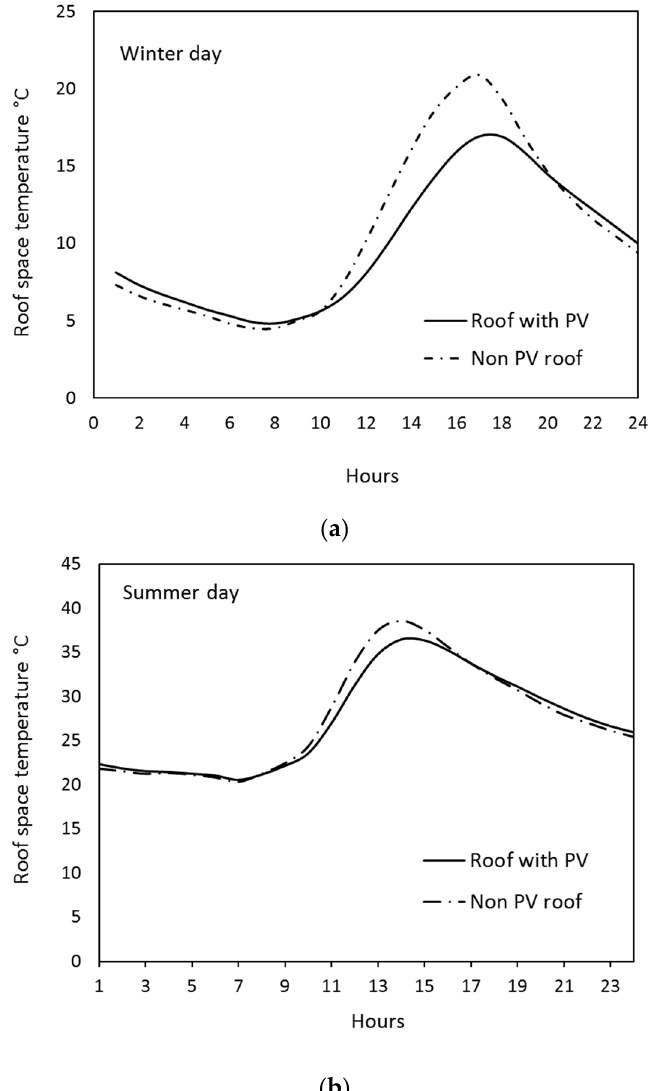
Figure 9. Roof space temperature profile in ( a ) winter and ( b ) summer days of a house with a ceiling insulation R value of 4 m 2 · °C/W.